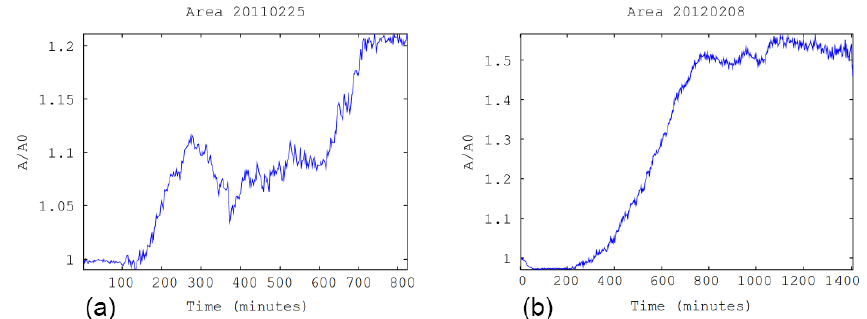
Figure 13. Ratio of the area of the triangle formed by the selected three VBs with respect to the area in the beginning of the period for the 2011 case (a) and for the 2012 case (b) .